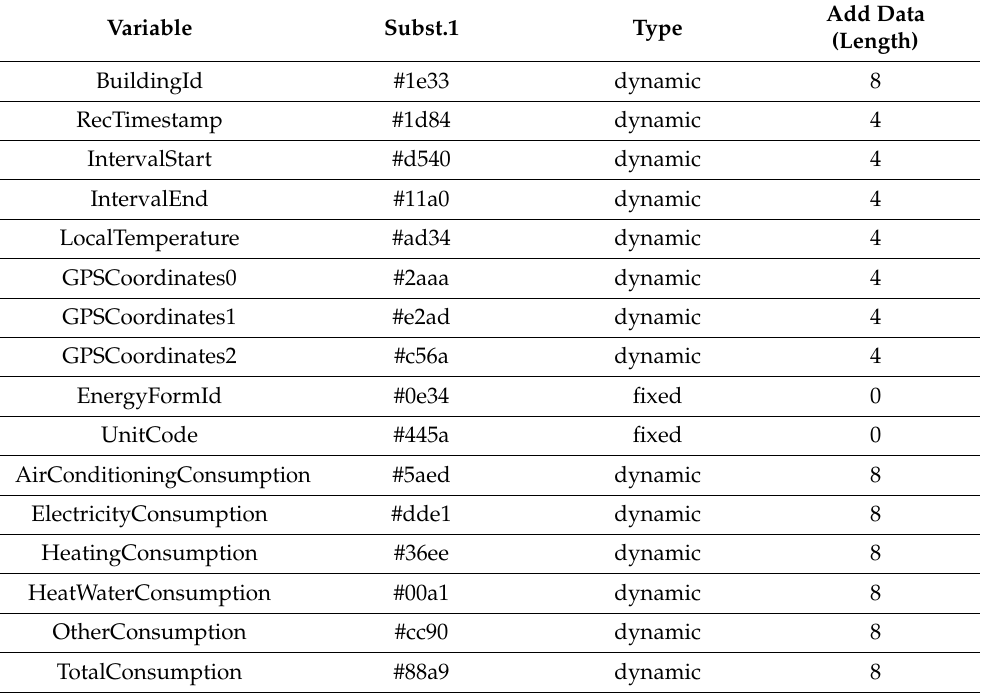
Table 2. SIEA device